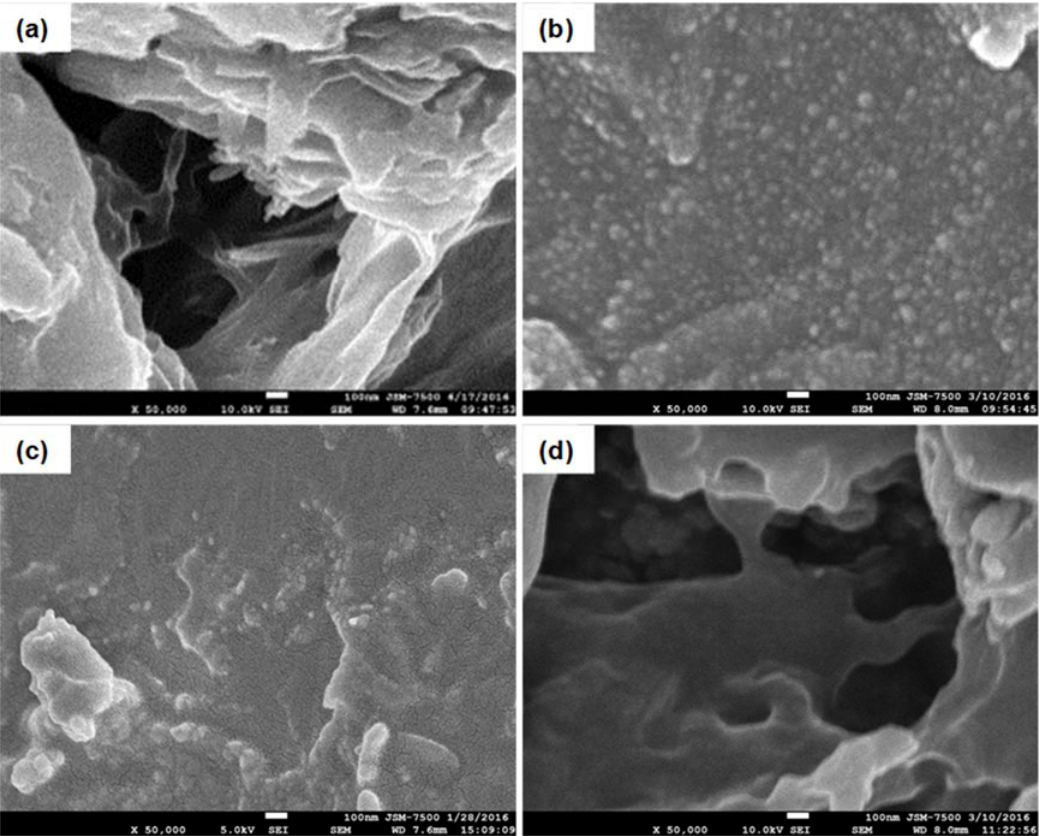
Figure 5 . SEM pictures of ( a ) Cu; ( b ) CVD graphene (C 2 H 2 , 600 °C, 5 min) on Cu; ( c ) CVD graphene Figure 5. SEM pictures of ( a ) Cu; ( b ) CVD graphene (C 2 H 2 , 600 ◦ C, 5 min) on Cu; ( c ) CVD graphene (CH 4 , 350 °C, 5 min) on Cu; ( d ) CVD graphene (CH 4 , 500 °C, 5 min) on Cu after the electrochemical (CH 4 , 350 ◦ C, 5 min) on Cu; ( d ) CVD graphene (CH 4 , 500 ◦ C, 5 min) on Cu after the electrochemical corrosion experiments with a total of 30 scans. corrosion experiments with a total of 30 scans.